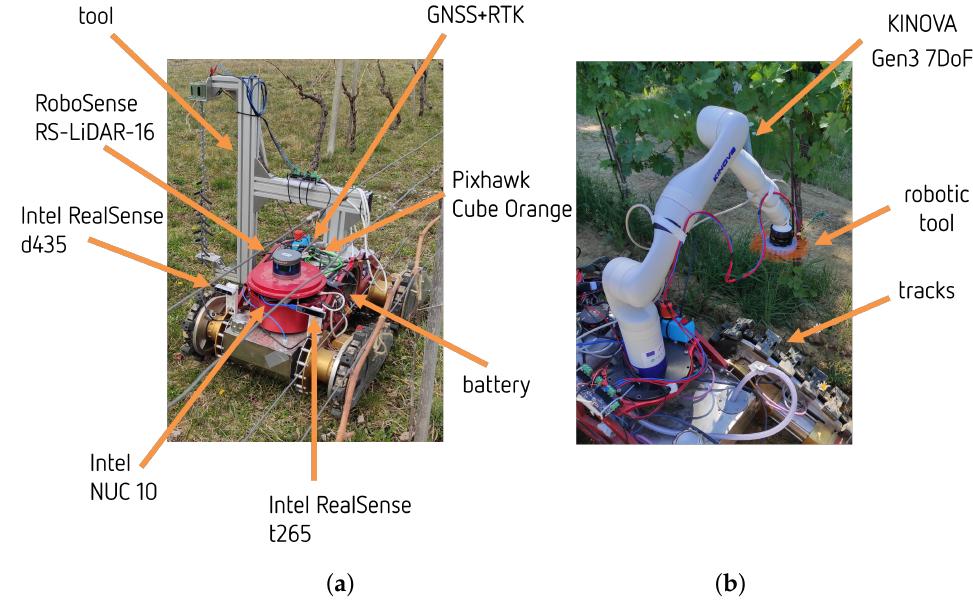
Figure 2. Design of an all-terrain mobile manipulator (ATMM-VIV) driven by four independently controlled flippers/tracks in two possible configurations. ( a ) Robotic tool with one degree of freedom (shaft rotation). ( b ) The 7 DoF robot arm with